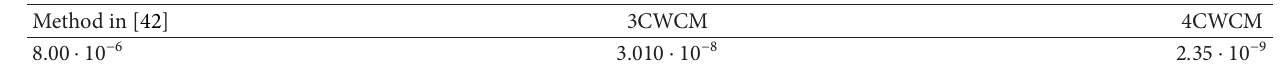
Table 7: The best errors for Example 4.